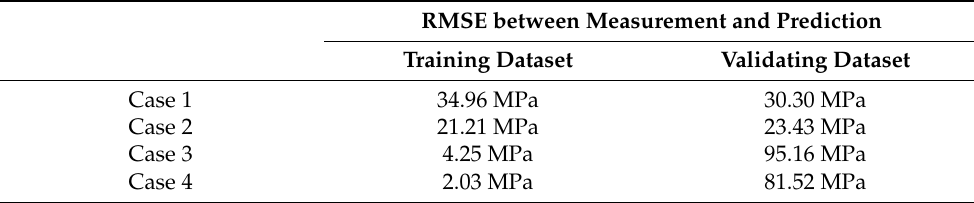
Table 2. RMSE between the experimentally measured and ANN-predicted flow